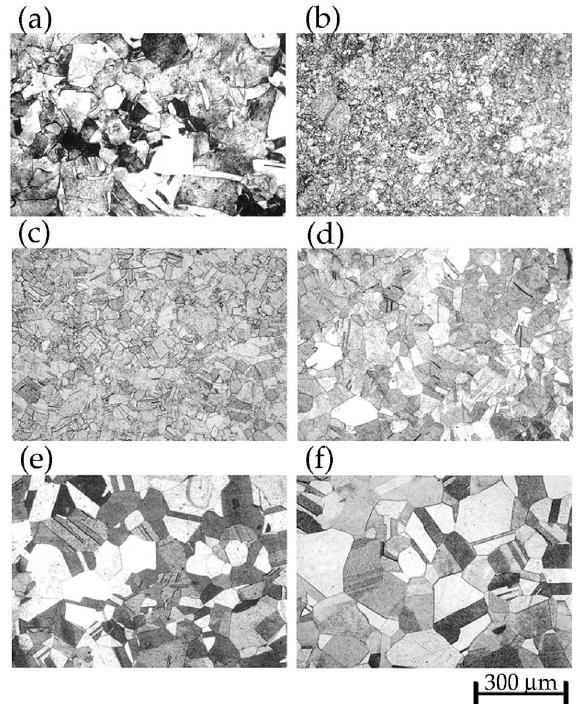
FIG. 4. Microstructures of high purity copper after annealing in vacuum for 30 min at (a) room temperature as received, (b) 600 ± C, (c) 700 ± C, (d) 800 ± C, (e) 900 ± C, and (f) 1000 ±